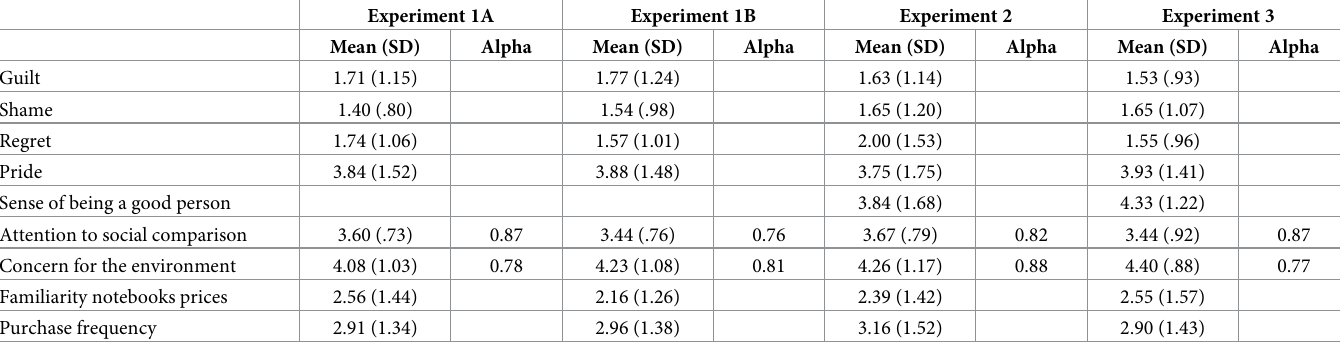
Table 3. Descriptive statistics for all